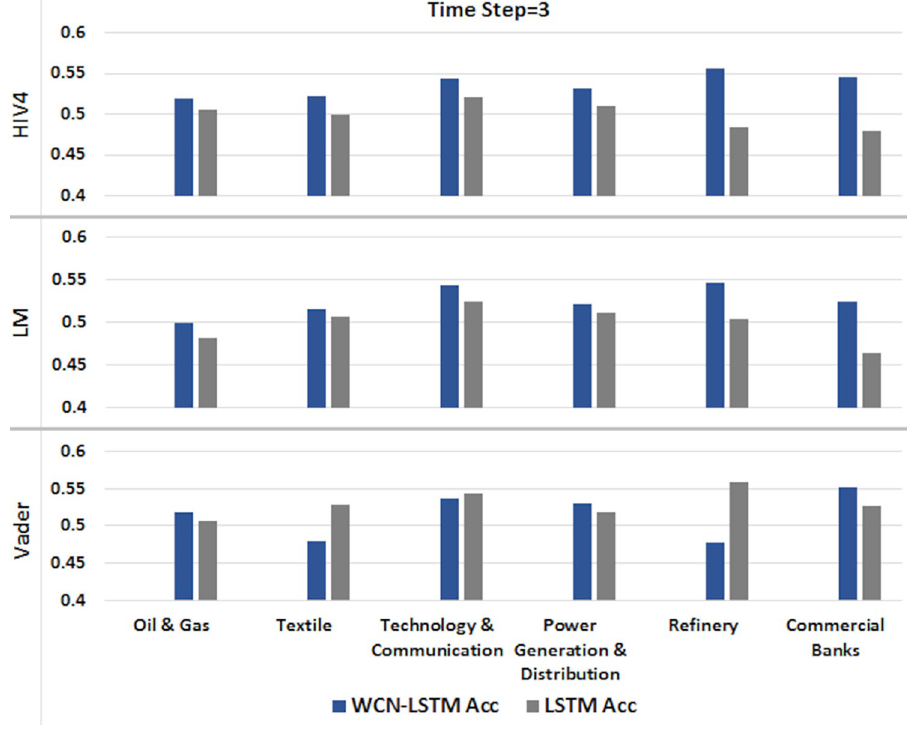
Fig 10. Comparison among sectors for time step =